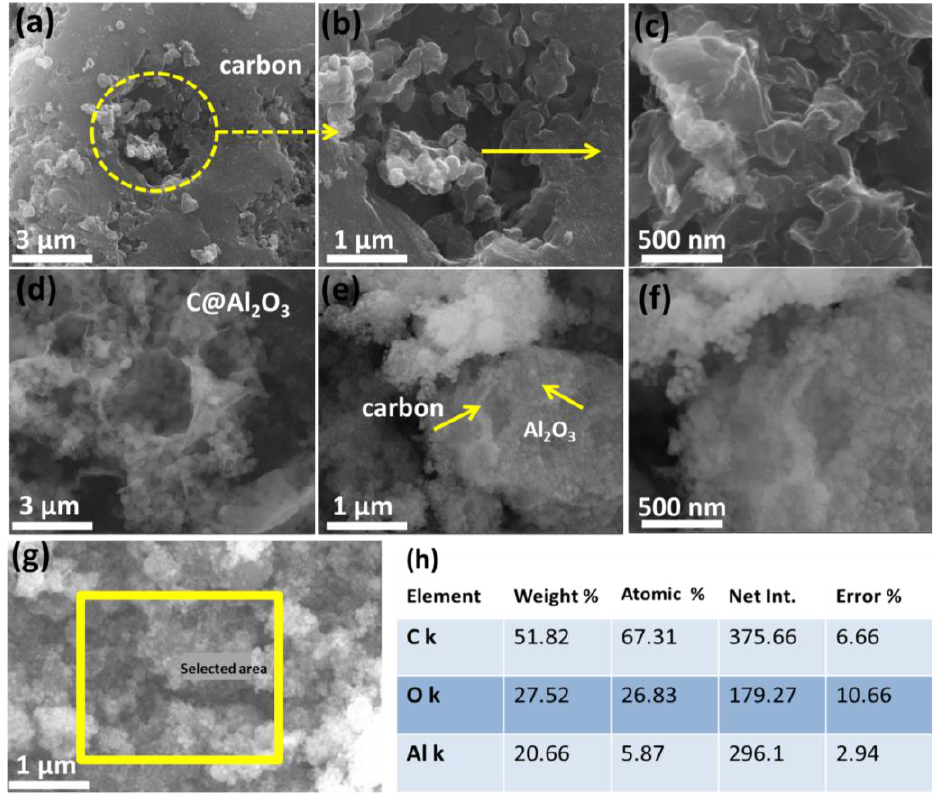
Figure 2. SEM images of cherry-blossom-derived porous carbon. ( a , b ) Porous morphology, ( c ) deep holes areas, ( d – f ) hybrid C@Al 2 O 3 composition wrapped with a carbon wall, ( g ) EDS of C@Al 2 O 3 selected area, ( h ) corresponding elements fraction of C, O, and Al in C@Al 2 O 3